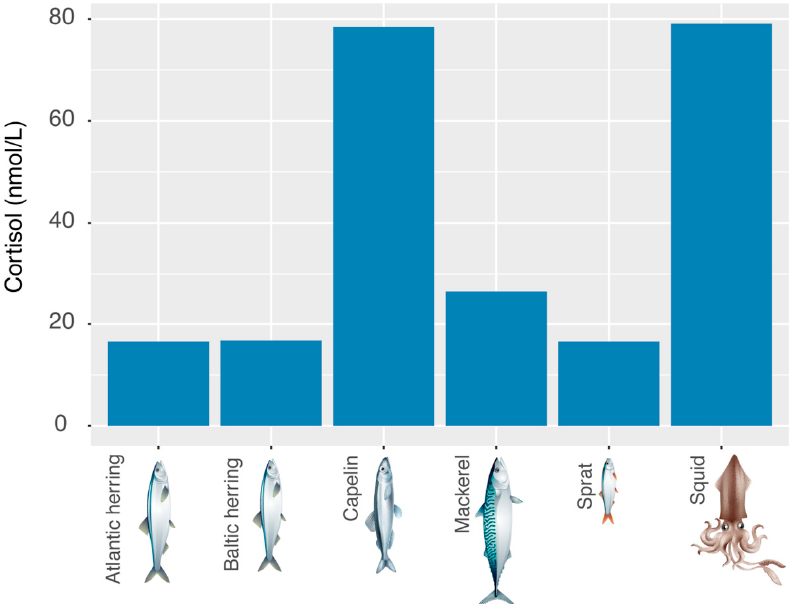
Figure 7. Cortisol values of different fodder fish and cephalopods. We measured samples taken from the thawing water of a 20 kg block of Atlantic herring, a 15 kg block of Baltic herring, a 5 kg block of capelin, a 20 kg block of mackerel, an 8 kg block of sprat and an 8 kg block of squid.